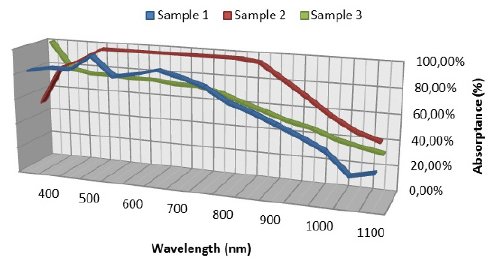
Figure 4. The absorptance curve for three CuInSe 2